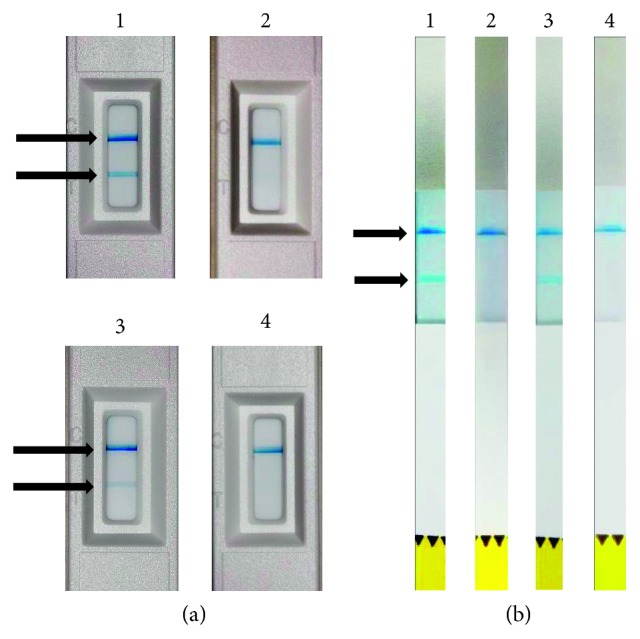
Periodontitis (a) results based on PerioSafe®-mouth-rinse test: two chronic periodontitis patients (1) and (3) before and (2) and (4) after nonsurgical periodontal treatment, scaling, and root planning (SRP). The appearance of two lines (>20 ng/ml) pointed by arrows in the figure is a considered positive test which indicates elevated risk for periodontitis. The appearance of only one line indicates successful test performance and no risk for periodontitis (aMMP-8 < 20 ng/ml) after SRP treatment. Peri-implantitis (b) results based on ImplantSafe®-PISF-strip-test; two peri-implantitis patients (1) and (3) before and (2) and (4) after peri-implantitis treatment (plastic scaling, oral hygiene instructions, and use of chlorhexidine). Two lines in the result window indicate elevated aMMP-8 in PISF and increased risk for peri-implantitis. The appearance of a single line indicates successful test performance, low aMMP-8 in PISF, and no risk for peri-implantitis after treatment [78, 84].